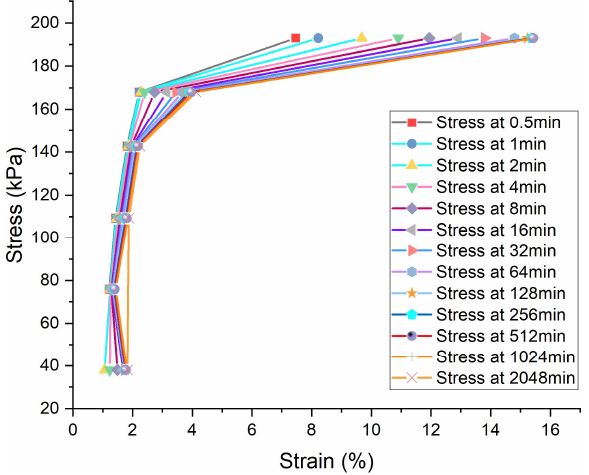
Figure 22. Isochronous ( σ 1 − σ 3 ) - ( ε 1 ) curves of Specimen No. 24, 7 FTHs.